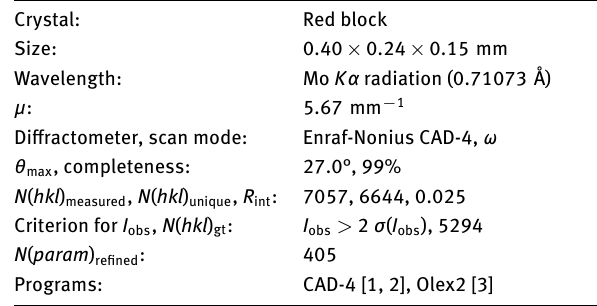
Table 1: Data collection and